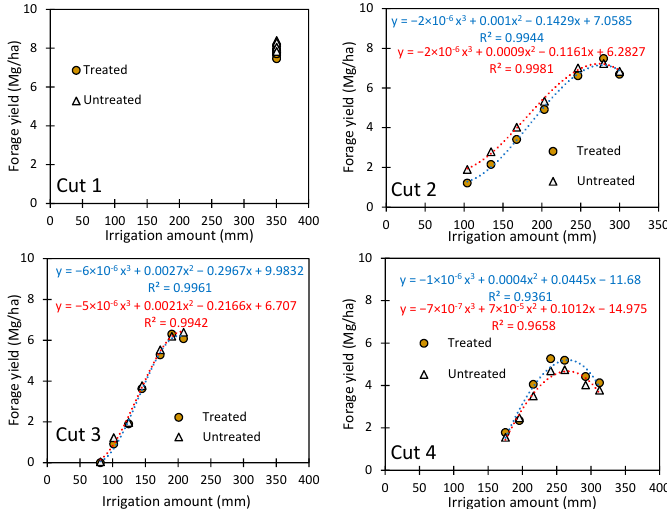
Figure 2. Forage yield as a function of irrigation amount at each cut during the 2013 growing season. Water 2020 , 12 , 1721 y = −1×10 -6 x 3 + 0.0007x 2 −0.1092x + 5.5792 R² = 0.9976